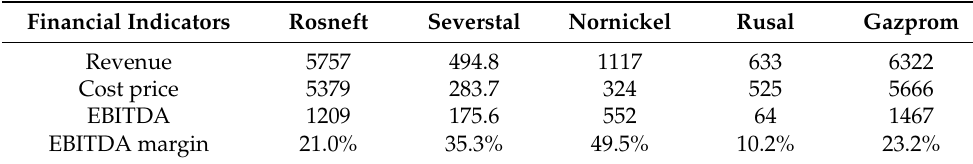
Table 3. Financial indicators, billion rubles.